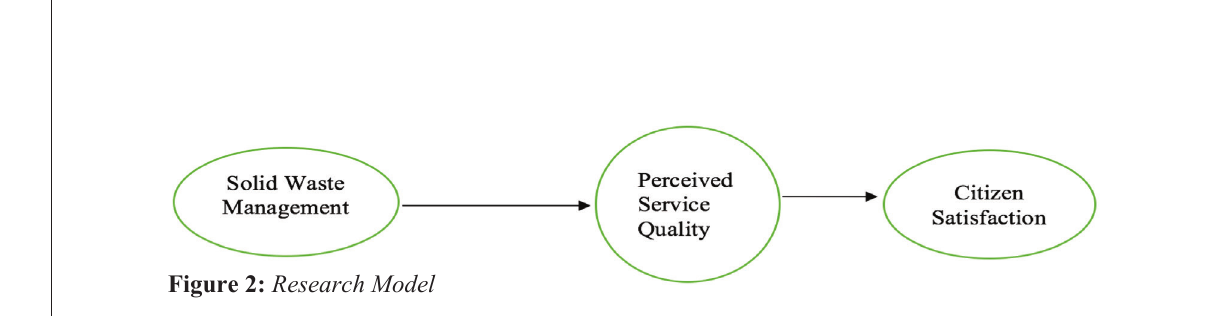
Figure 2: Research